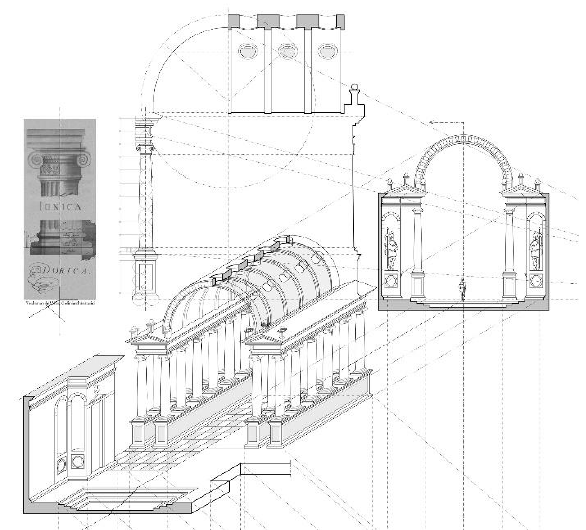
Figure 3. Axonometric reconstruction of the imaginary architecture drawn in figure 2 (Drawing by S. Chiarenza)